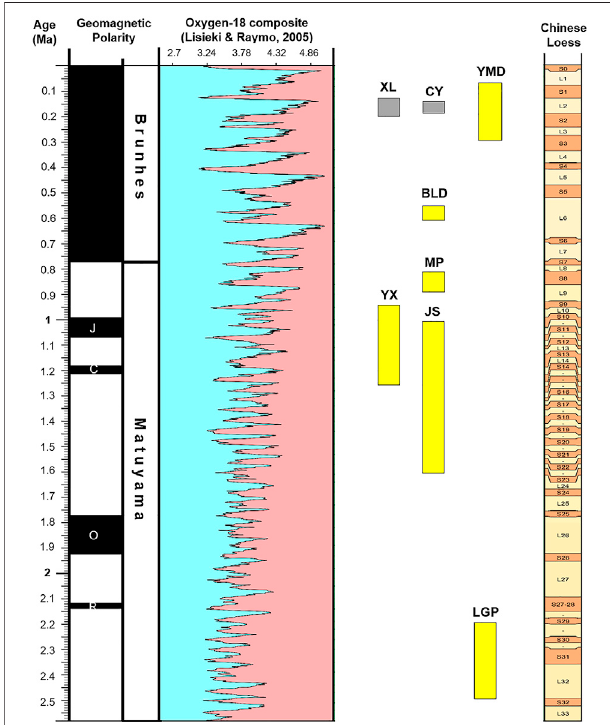
FIGURE 5 | Chronological and paleoenvironmental summary of the hominin sites in the TGR dated by radiometric methods. The age bars with golden color are obtained by the coupled ESR/U-series method, and the gray color was yielded by other radiometric dating methods (the chart was generated by TimeScale Creator GTS